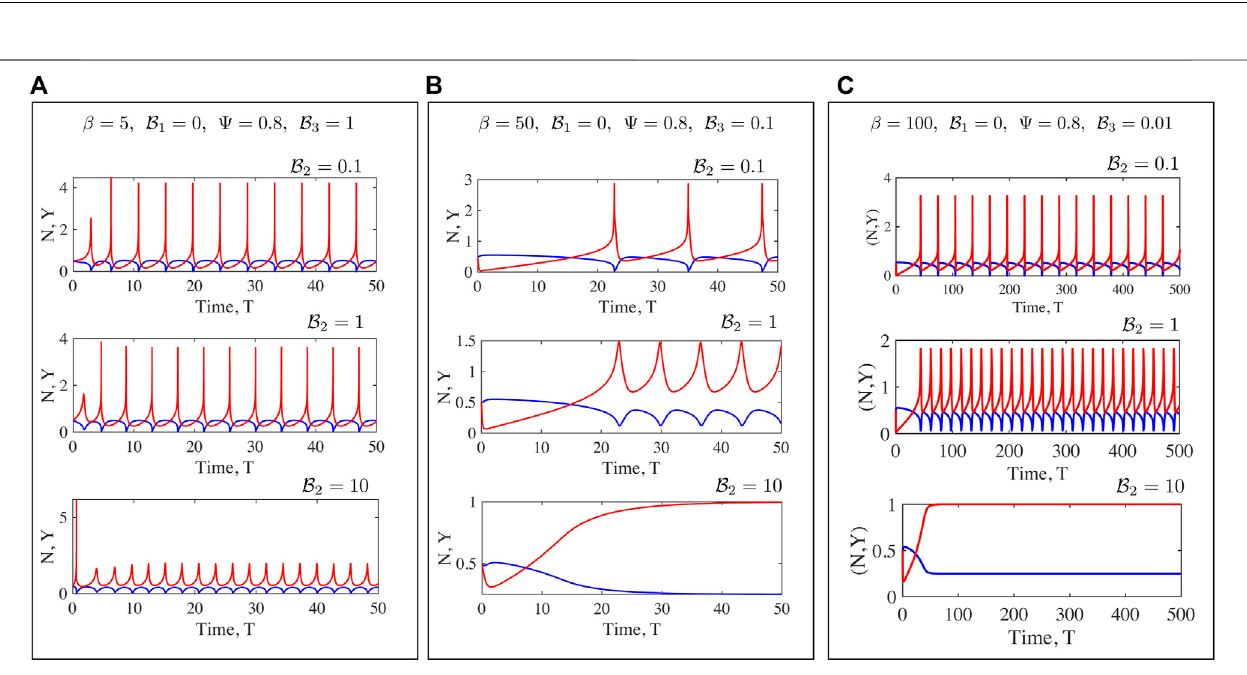
2 (top to bottom).